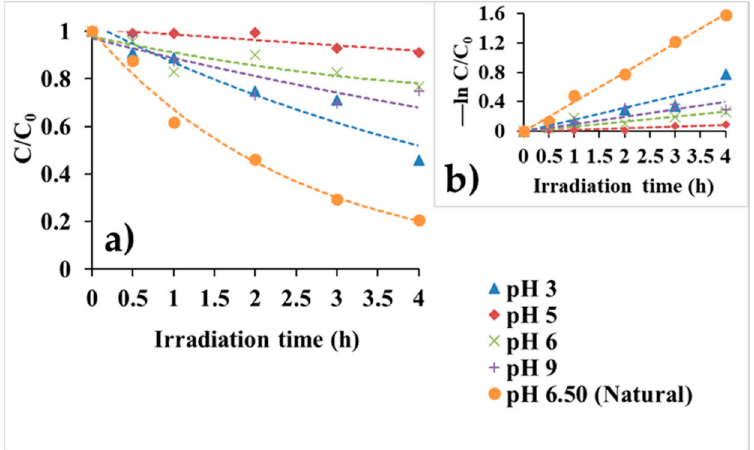
Figure 9. ( a ) pH effects on TiO 2 /ZnO/CuPc catalyst degradation efficiency for IBF (C 0 = 5 mg/L) removal, and ( b ) corresponding degradation rate